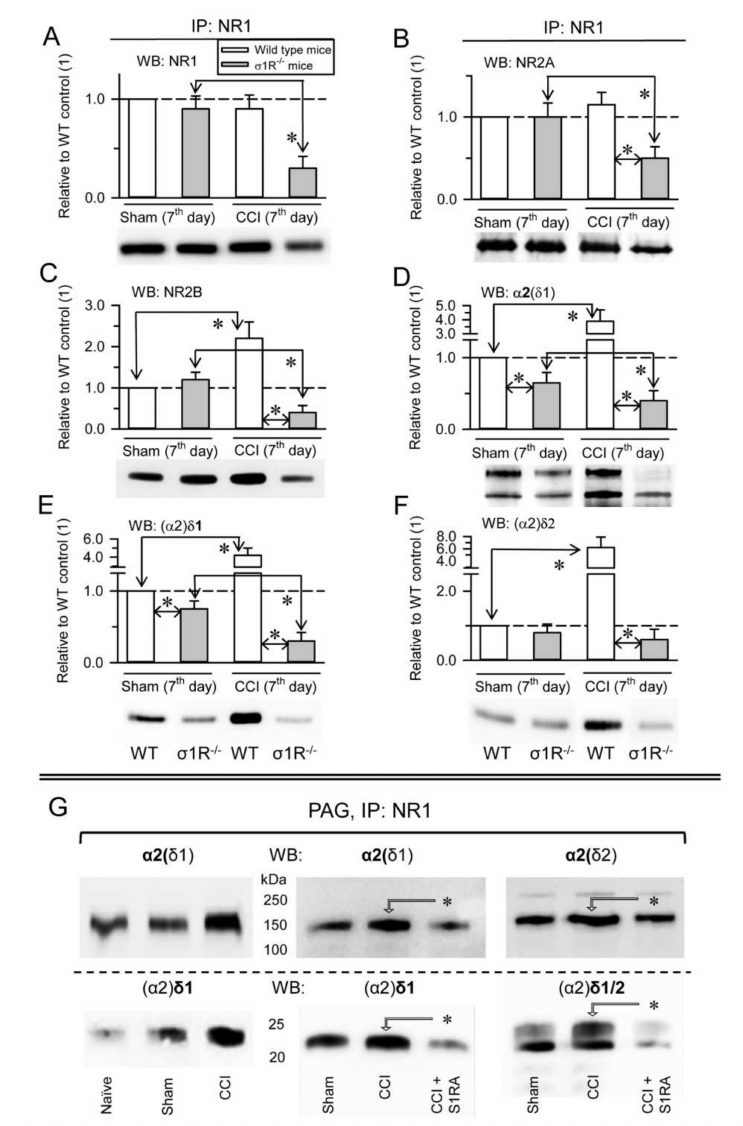
Figure 5. CCI promotes σ 1R-mediated associations of α 2 δ 1-2 proteins with NR1 subunits. ( A ) CD1 WT sham-operated ( n = 4), CD1 WT CCI ( n = 4), CD1 σ 1R − / − sham ( n = 4) and CD1 σ 1R − / −